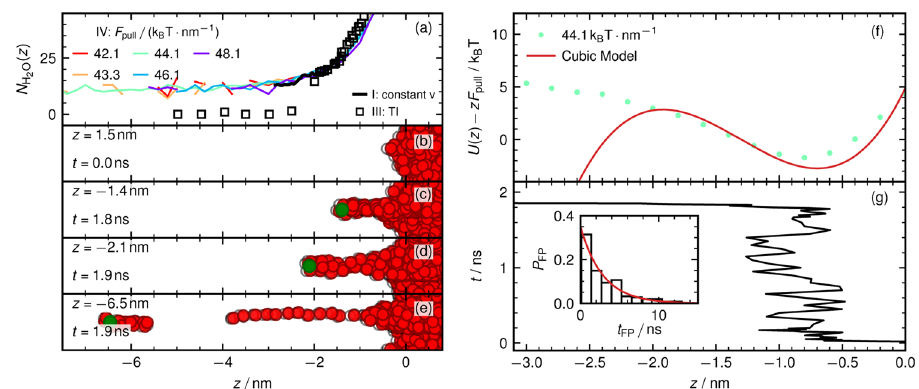
Fig. 4 Ion dynamics with externally applied force. Simulation protocol (IV) where a constant force F pull acts on the chloride ion. a Number of water molecules N in a spherical sphere with radius 1 nm around chloride as function of position. Colored lines are simulations at constant force F pull . The black H 2 O line shows results from constant velocity simulations (protocol I, Fig. 1h) and black open squares show TI simulations (protocol III, Fig. 3b). b – e Snapshots at different ion positions for F pull = 44.1 k B T ⋅ nm − 1 . f Free energy for F pull = 44.1 k B T ⋅ nm − 1 , green dots show results from the ion distribution of 200 simulation runs, the red solid line is the cubic polynomial fi t from Fig. 3b. g Ion trajectory corresponding to snapshots in ( b – e ). The inset shows a histogram of fi rst passage times for 200 simulation runs with an exponential fi t (solid red line). A simulation video of an evaporating chloride ion is available in Supplemental Movie 2 and online https://youtu.be/LVAHxCInzIU.